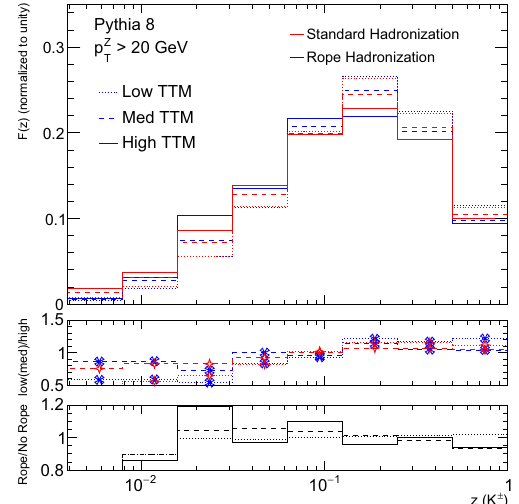
tolowmultiplicityforbothhadronizationmodels.Inthelowerpanel,the ratio between the Rope and standard hadronization models is displayed for all three multiplicity